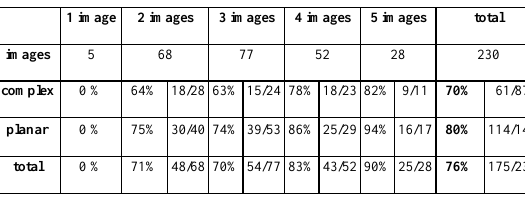
Table 1: Evaluation of the facade plane detection using the column-wise